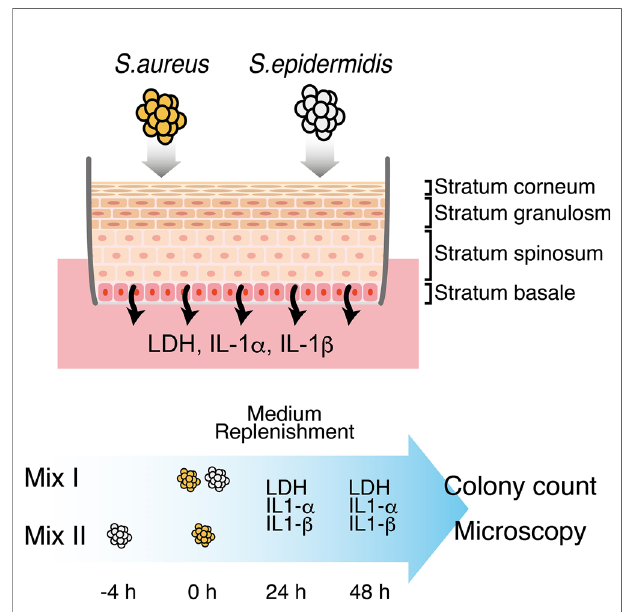
FIGURE 1 | Schematic representation of establishing the mixed infection model of S. aureus and S. epidermidis . S. aureus and S. epidermidis were inoculated onto the surface of a fully-differentiated, strati fi ed 3D epidermal model following two different protocols: (I) S. aureus and S. epidermidis were pre-mixed and inoculated simultaneously; (II) S. epidermidis was inoculated 4h prior to S. aureus . Culture media were replenished at 24h and collected at 24h and 48h to monitor the extracellular levels of LDH, IL-1 a and IL-1 b . At 48h, S. aureus and S. epidermidis on the surface of the 3D epidermal model were harvested and then enumerated by plate count. Intact epidermal tissues along with the Staphylococci were also preserved and processed for the analysis of bacterial distribution and migration using confocal fl uorescence